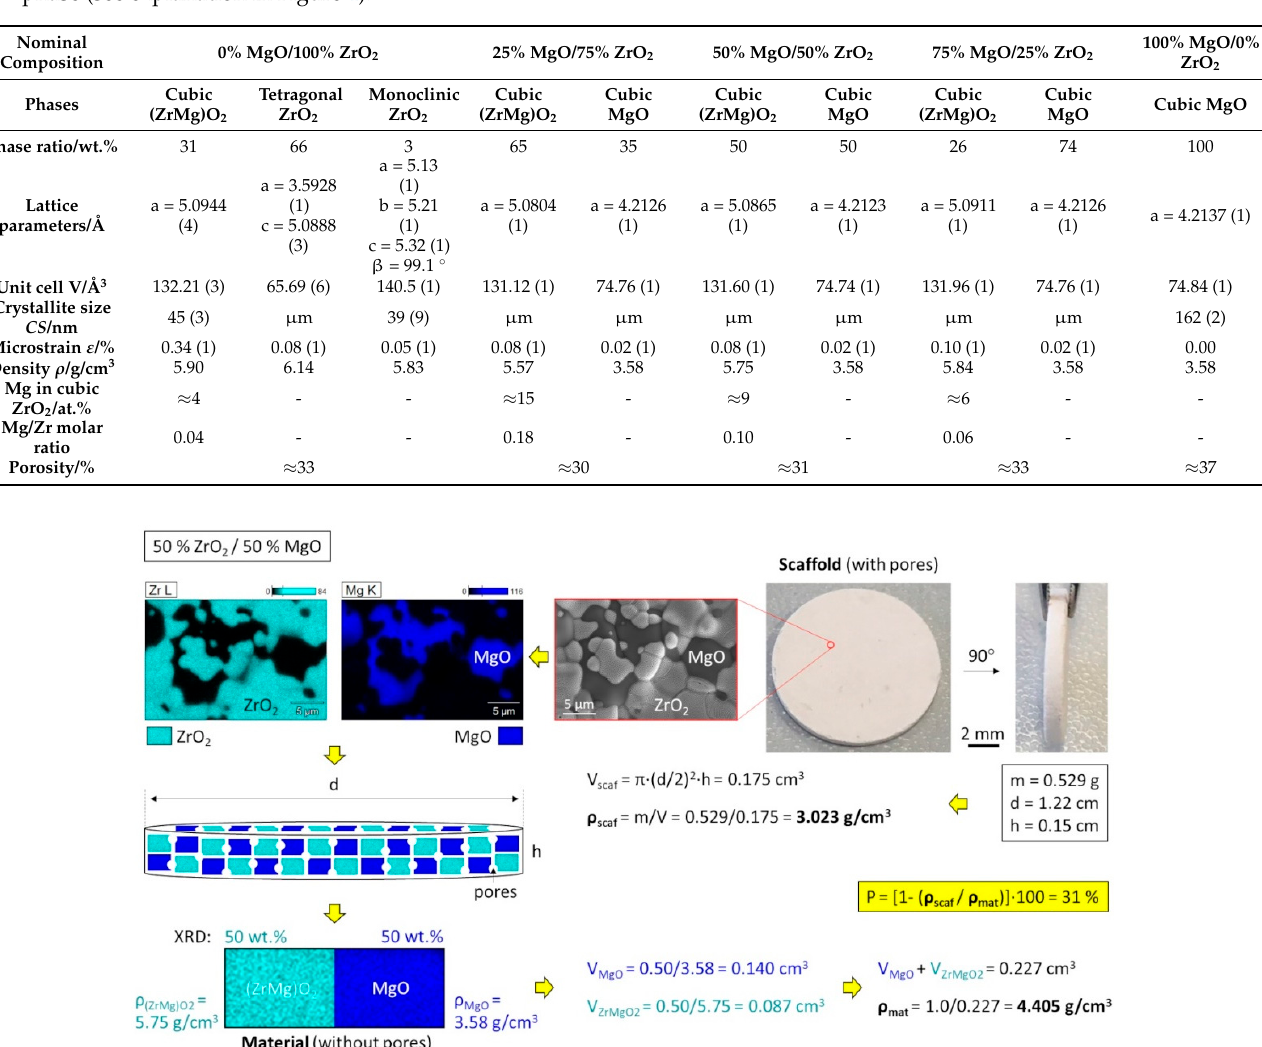
Table 1. Crystallographic parameters determined by Rietveld refinement in XRD for ZrO 2 /MgO ceramics. The porosity of the samples was calculated considering both the density (incl. effect of Zr/Mg substitution) and the weight amount of each phase (see explanation in Figure 4).